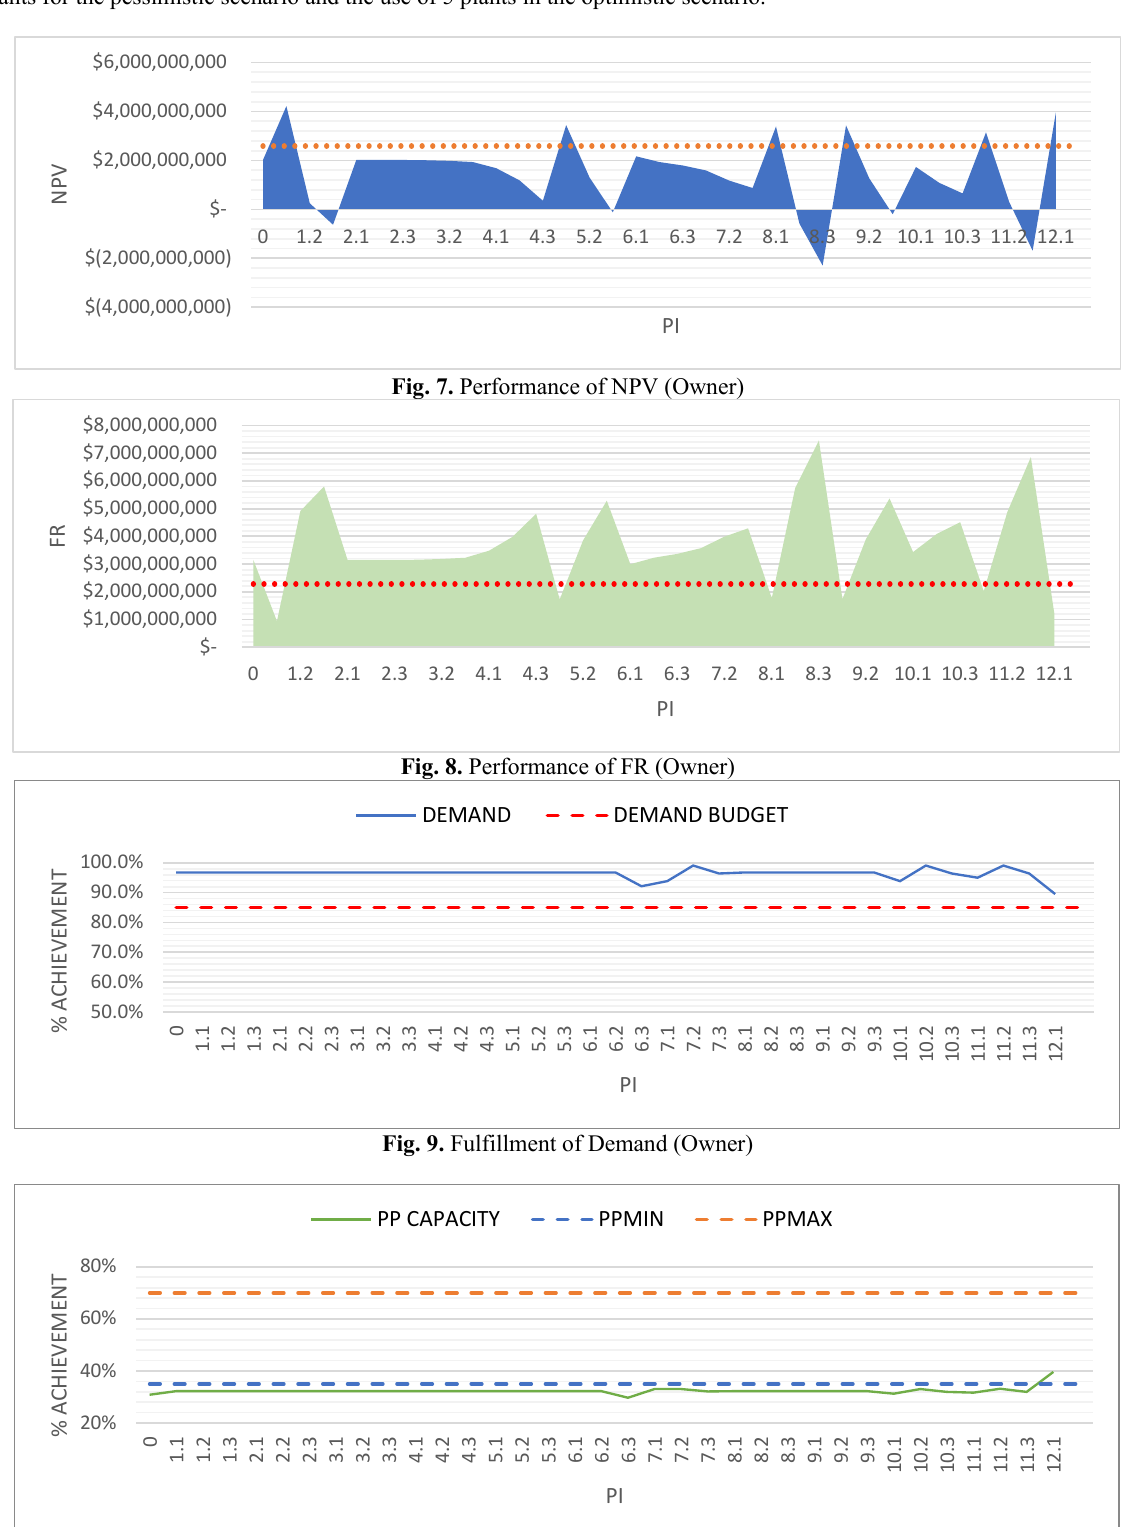
Fig. 10. Occupation of PP